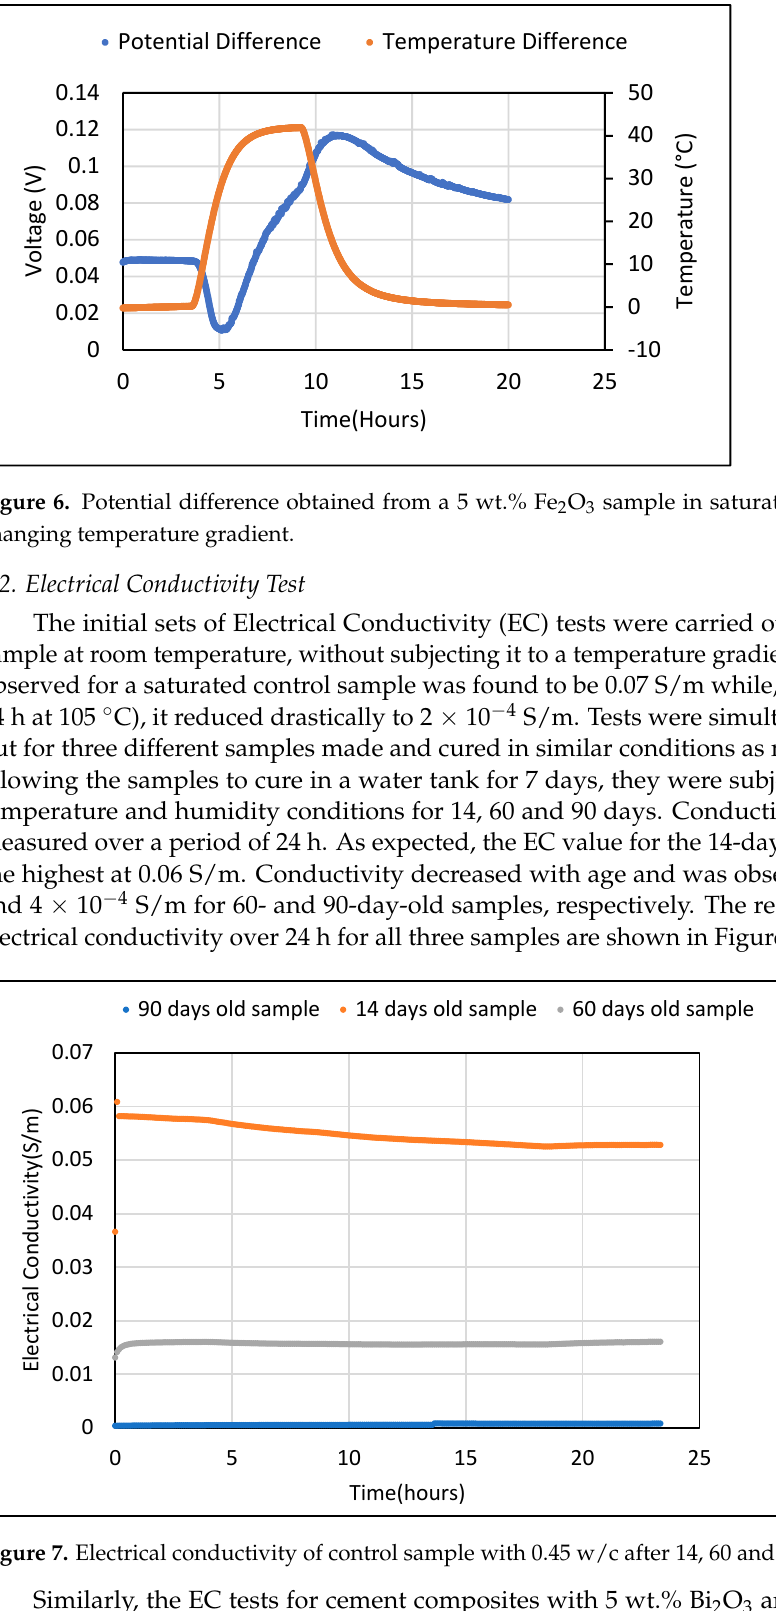
Figure 5. Voltage difference obtained from 5%wt. Bi 2 O 3 cement composite at constant temperature difference.